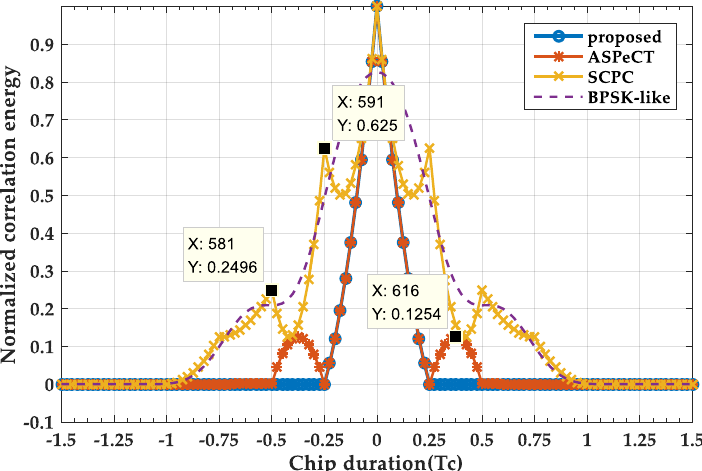
Figure 11. The 2-D acquisition result at M =